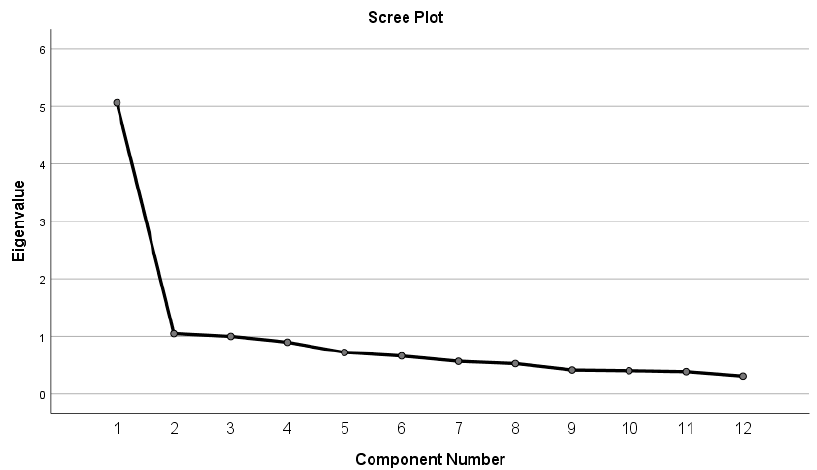
Figure 1. Scree plot demonstrating the elbow following the first component.